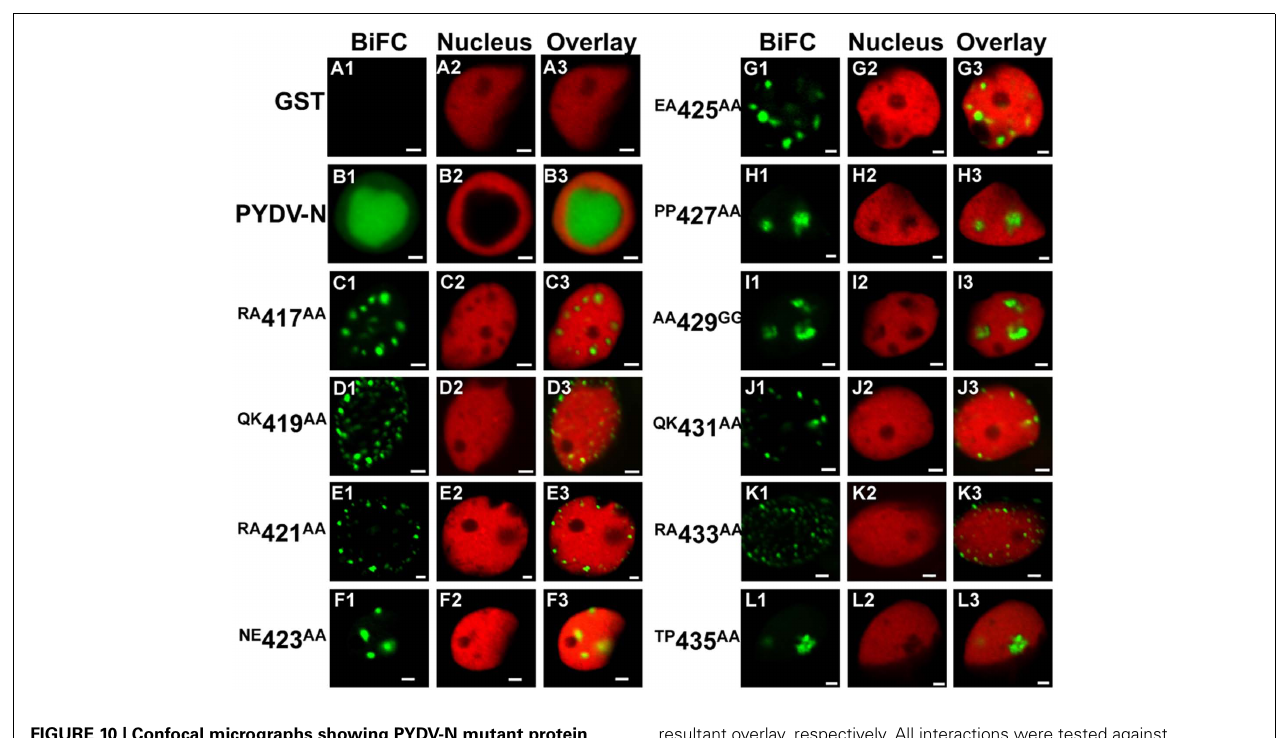
FIGURE 10 | Confocal micrographs showing PYDV-N mutant protein interactions with PYDV-M determined by BiFC. Interaction assays were conducted in leaf epidermal cells of transgenic N. benthamiana expressing a fluorescent nuclear marker (Nucleus). Panels 1, 2, and 3 show micrographs ofYFP (BiFC), nuclear marker (Nucleus), and the